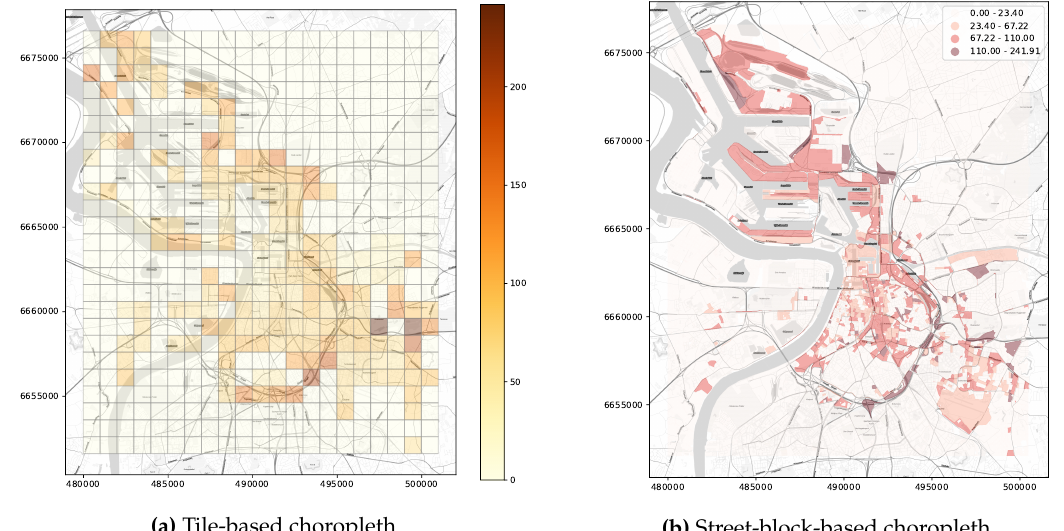
Figure 1. Examples of visualizations expected from an elementary exploratory task: These choropleth maps show the concentration of nitrogen dioxide ( NO 2 ) over the city of Antwerp, BE through a one-month